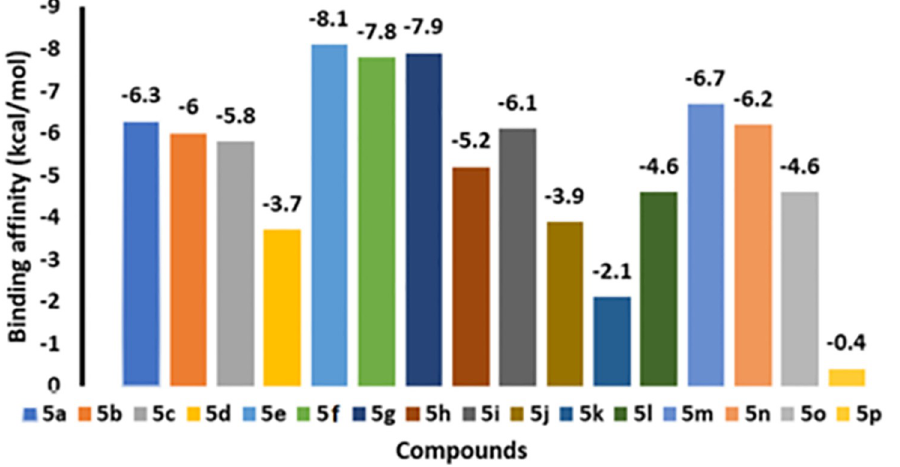
Fig 7. The graphical depiction of Binding affinity values of fuberidazole derivatives.